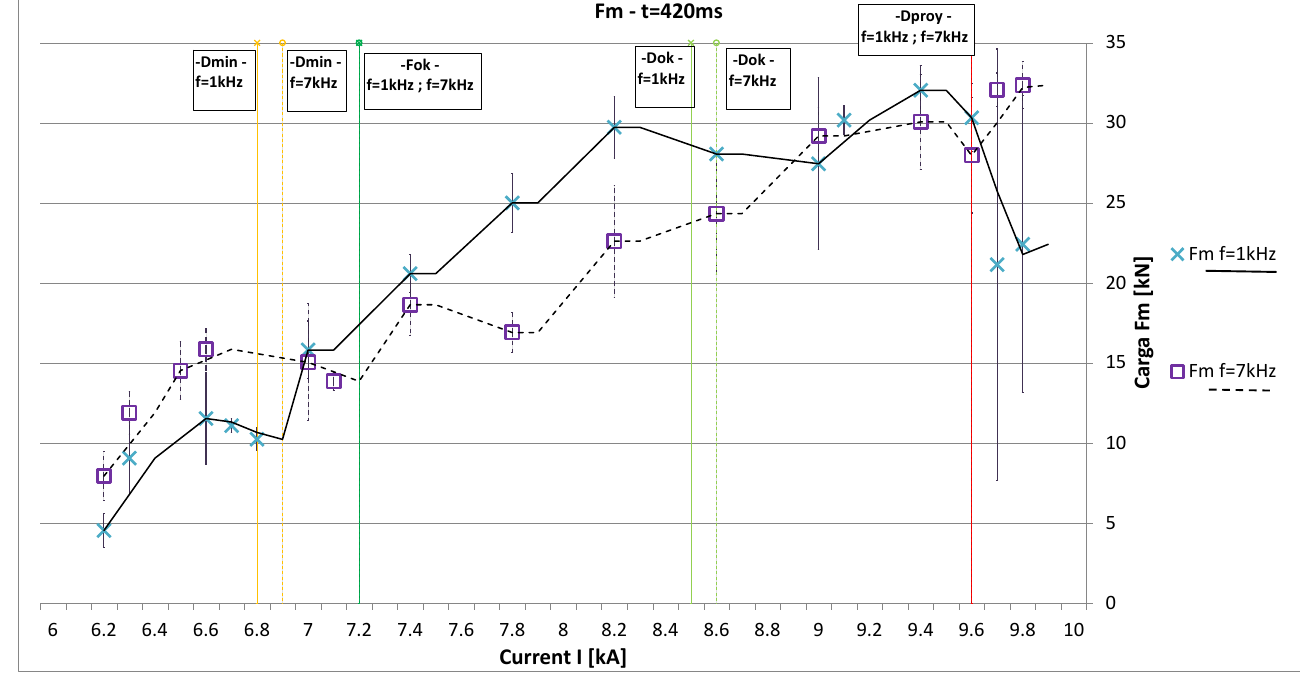
Figure 13. Shear tensile test for the study frequencies, 1 kHz and 7 kHz. Limit values D min and D proy and optimal F ok and D ok for both frequencies.